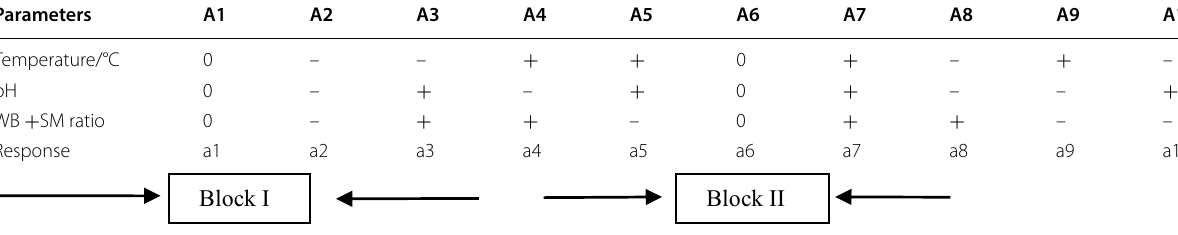
Table 1 Experimental design for three variables system